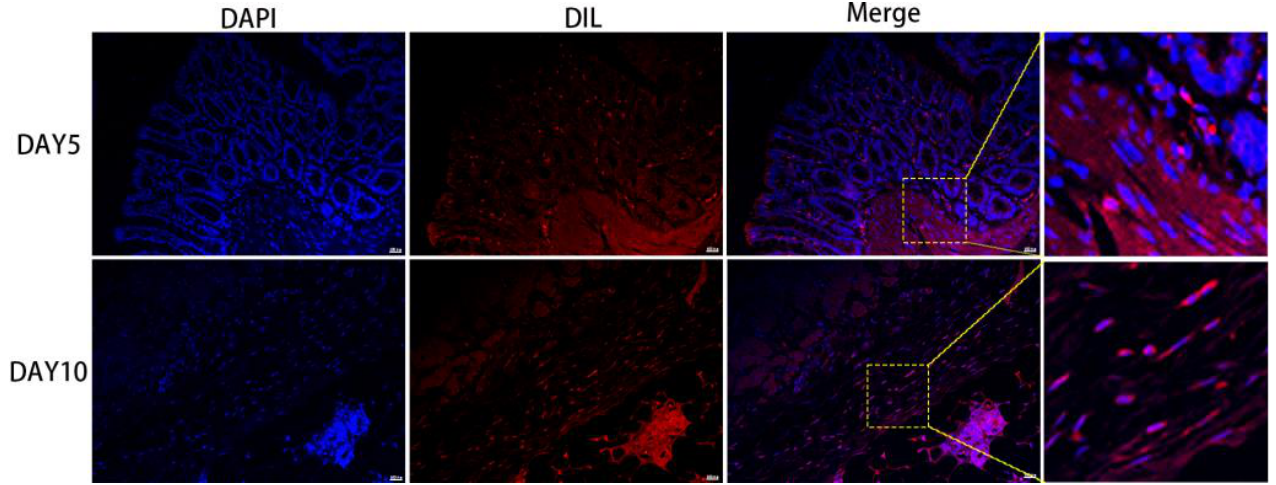
Figure 7. Fluorescence of DIL labeling after 5 and 10 days of treatment in CSVF group. Cell nucleus was stained in blue with DAPI, and DIL-labeled CSVF was visualized by red fluorescence.